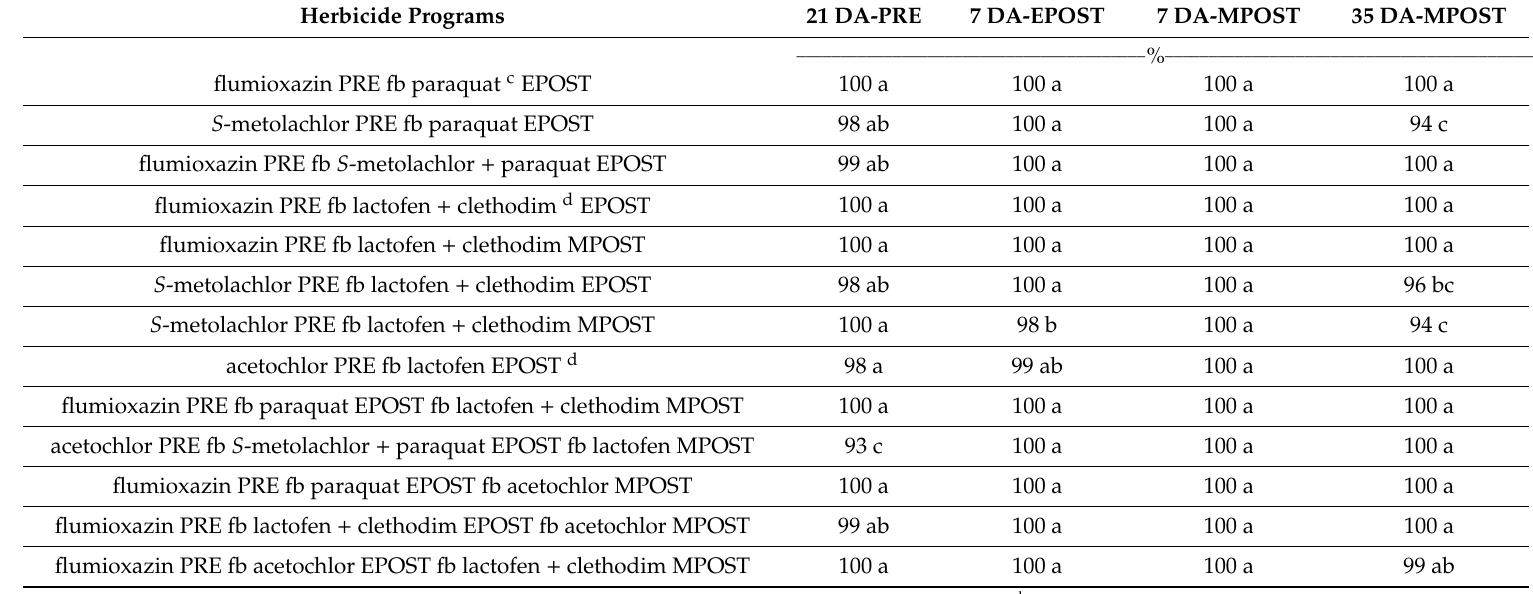
Table 7. Control of prickly sida 21 DA-PRE, 7 DA-EPOST b , and 7 and 35 DA-MPOST b treatments in Weed Control Study at Stoneville, MS averaged over 2017 and 2018 a